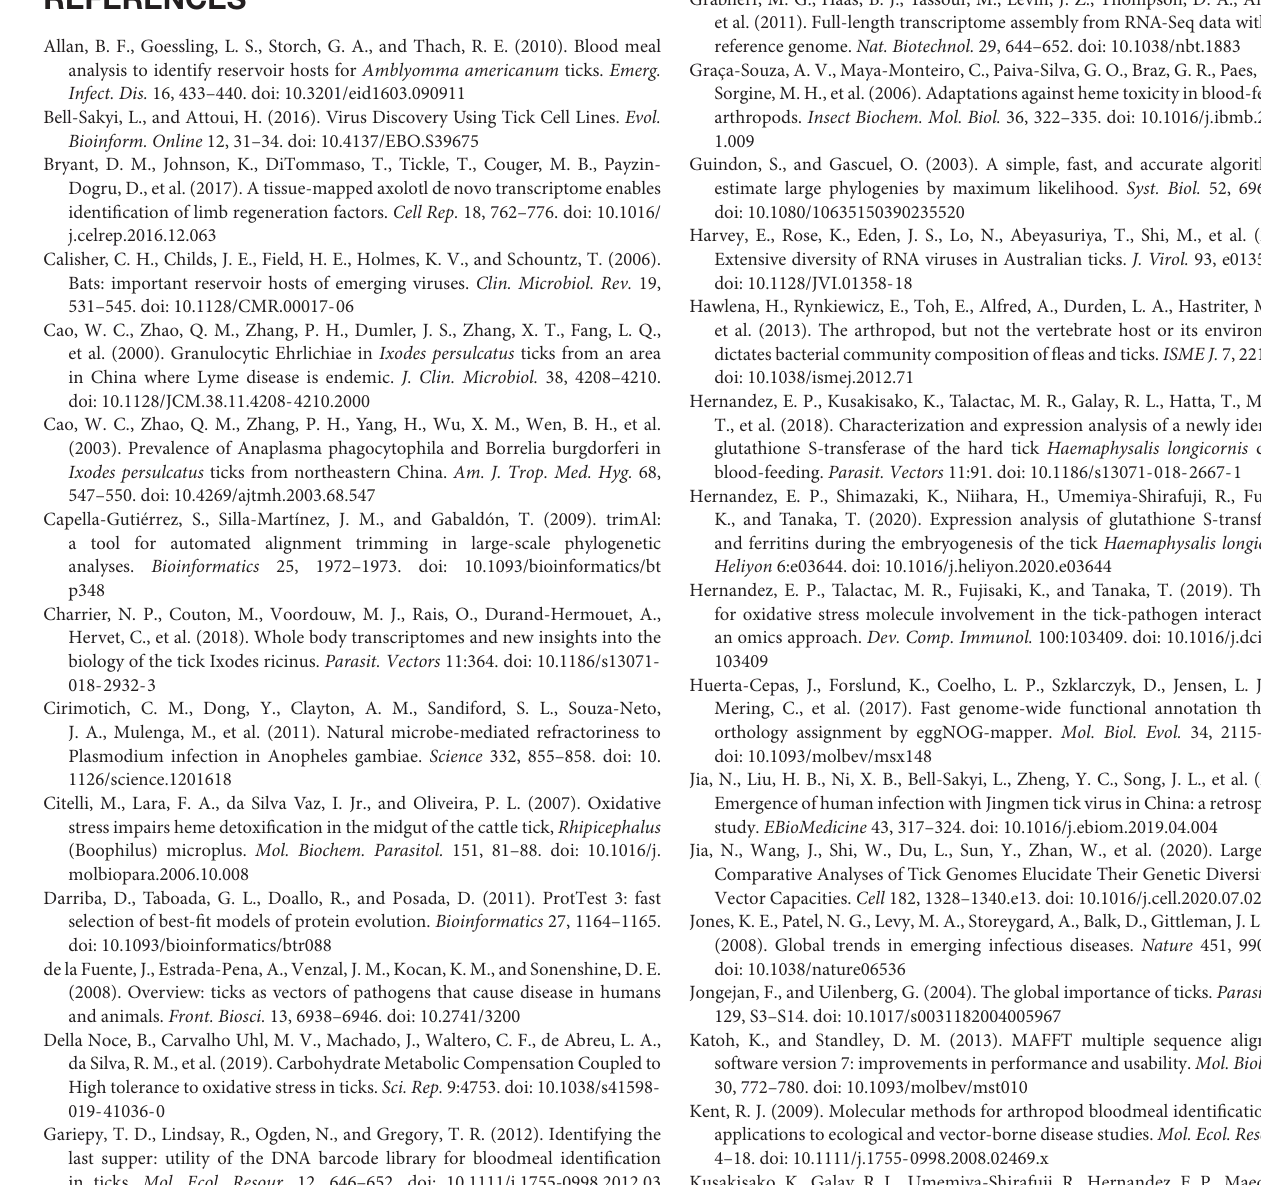
Supplementary Figure 1 | RNAseq analysis of tick gene transcripts detected in pools of flat and fully fed Ixodes persulcatus ticks removed from human patients at Mudanjiang Forestry Central Hospital in Heilongjiang Province, China. Heatmap with clusters showing the Pearson correlation matrix for pairwise sample comparisons of differentially expressed genes in flat (pools TG1, TG2, and TG13), and fully fed (pools TG5, TG6, and TG15) ticks. Supplementary Figure 2 | RNAseq comparison of tick gene transcripts detected in pools of flat and fully fed I. persulcatus ticks removed from human patients at Mudanjiang Forestry Central Hospital in Heilongjiang Province, China. Taxonomic classification of differentially expressed genes with similar expression patterns based on the Clusters of Orthologous Groups (COG) database (A) COG classification of genes upregulated in fed versus unfed ticks; (B) COG classification of genes downregulated in fed versus unfed